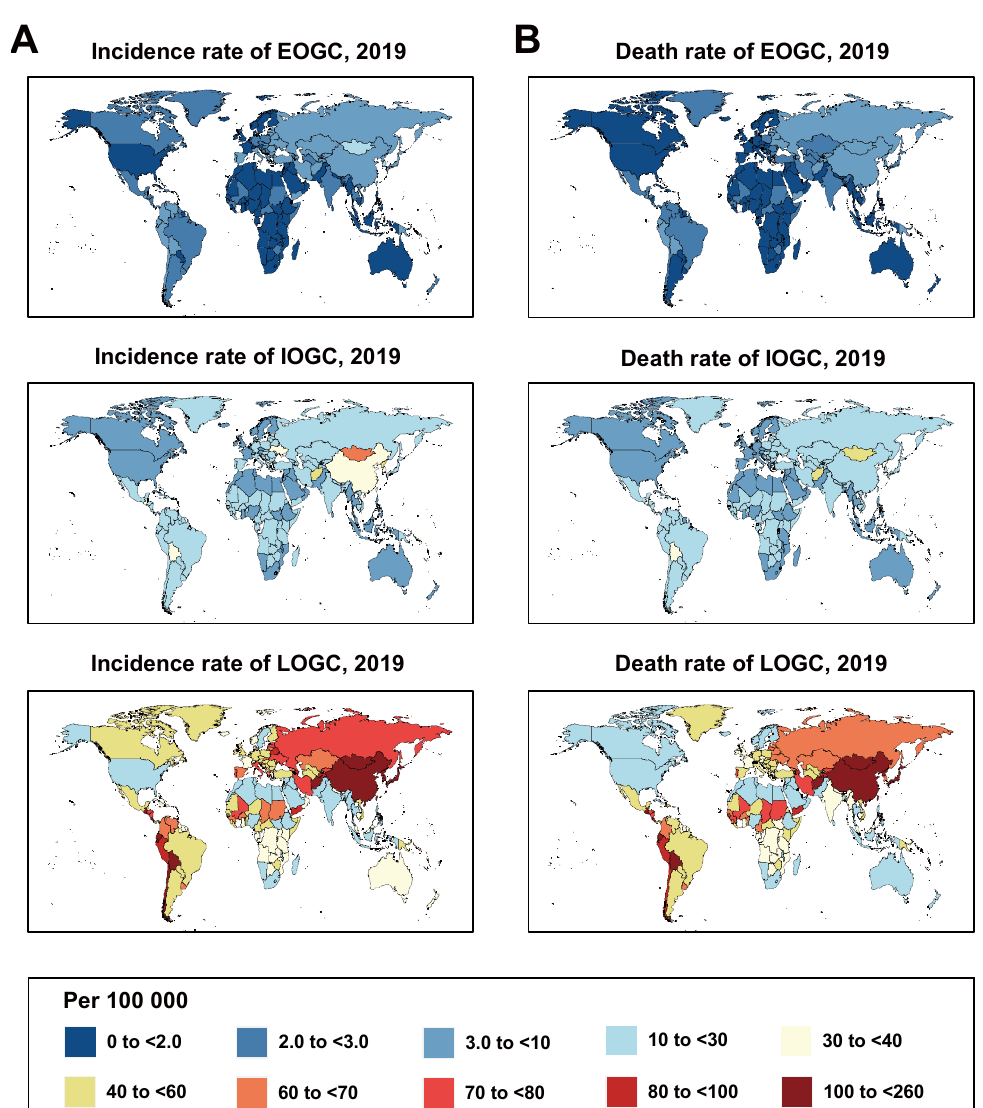
Figure 2. Incidence and death rates of gastric cancer globally in 2019. ( A ) Incidence rates of gastric cancer globally in 2019; ( B ) Death rates of gastric cancer globally in